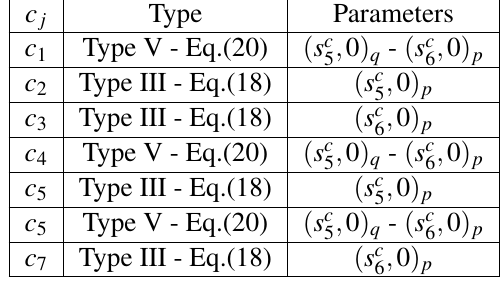
Table 8. Linguistic preference functions and its parameters